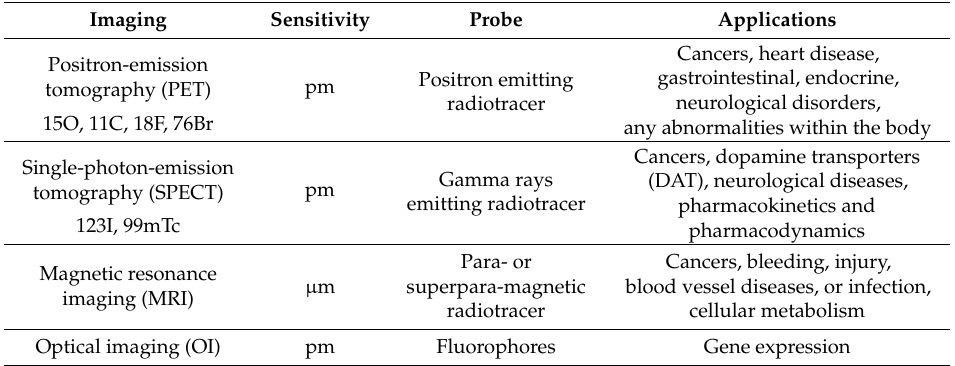
Table 1. Various techniques are available for molecular imaging in disease and drug